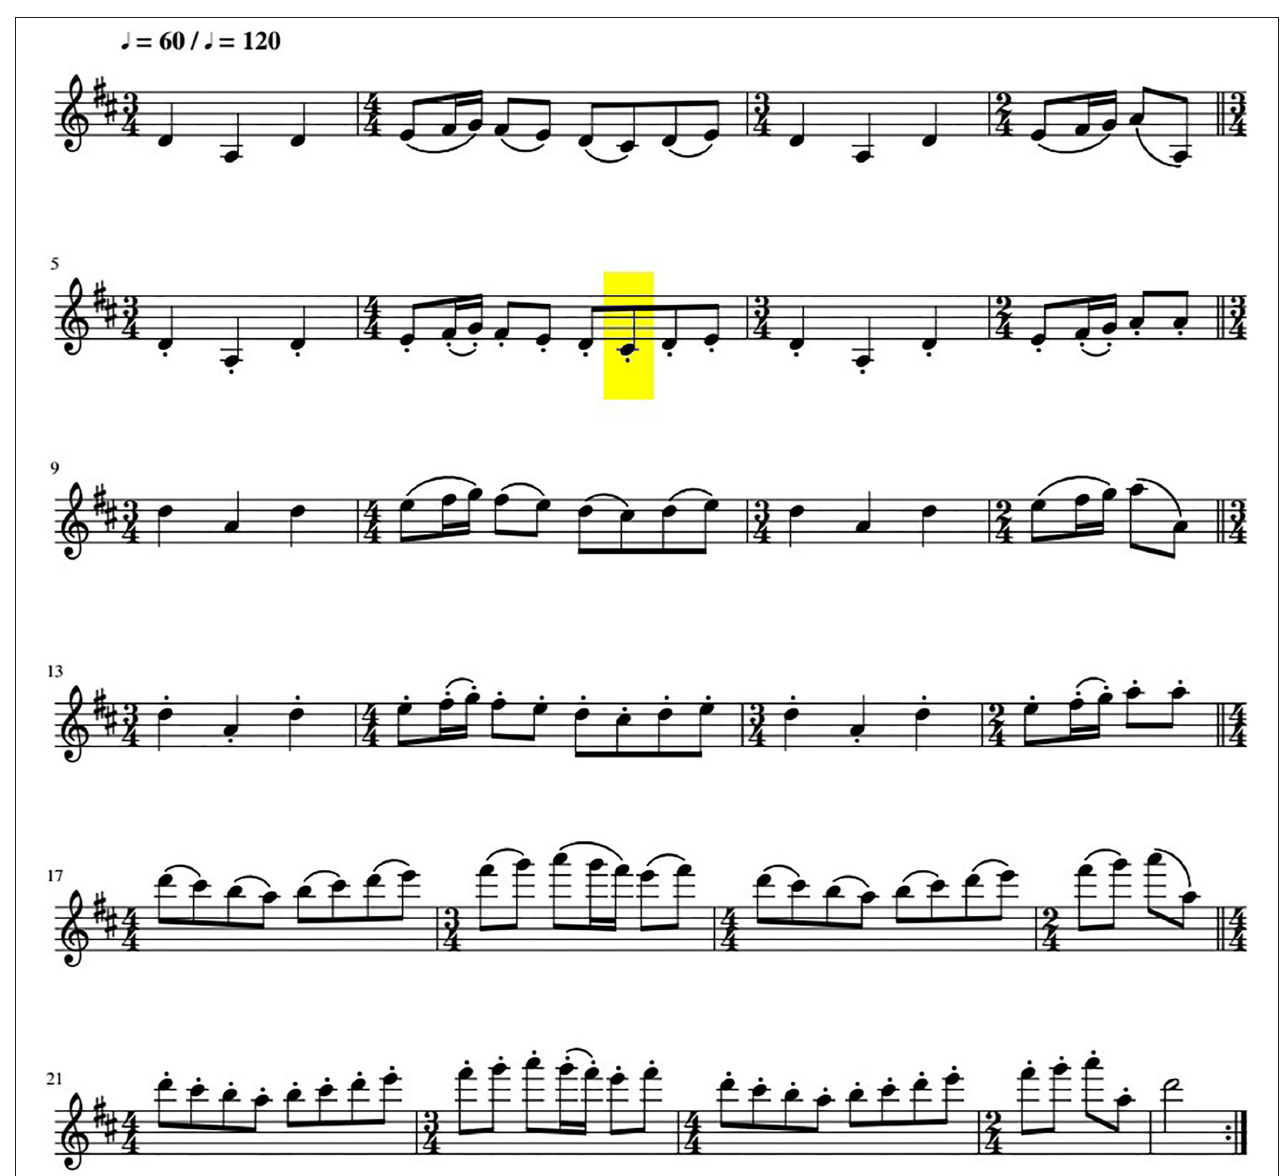
FIGURE 1 | The piece of music, consisting of two sections (spiccato, then legato), both played at three octaves. The C# analyzed using audio-descriptors is highlighted in yellow.